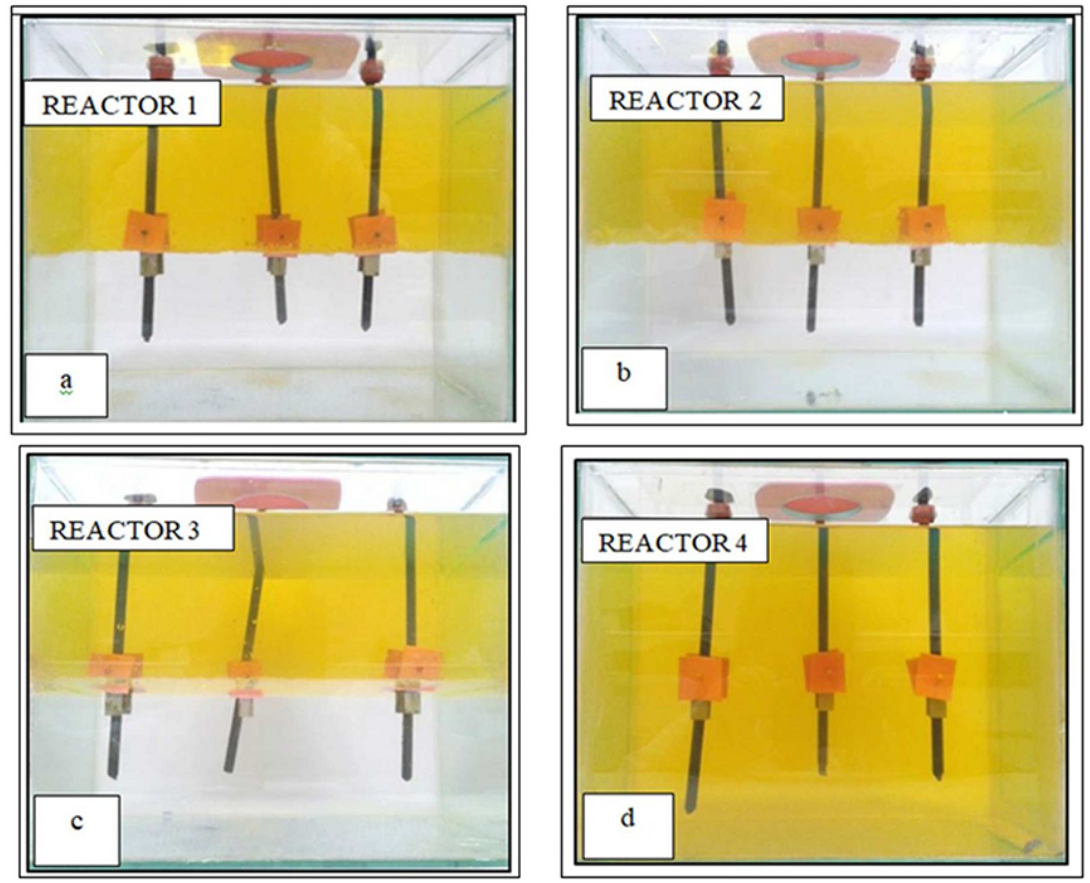
Figure 1. Reactors containing carbon steel A283, with 6 specimens in each reactor: (a) Reactor 1, immersion of 30 days; (b) Reactor 2, immersion of 60 days; (c) Reactor 3, immersion of 90 days and (d) Reactor 4, immersion of 90 days.